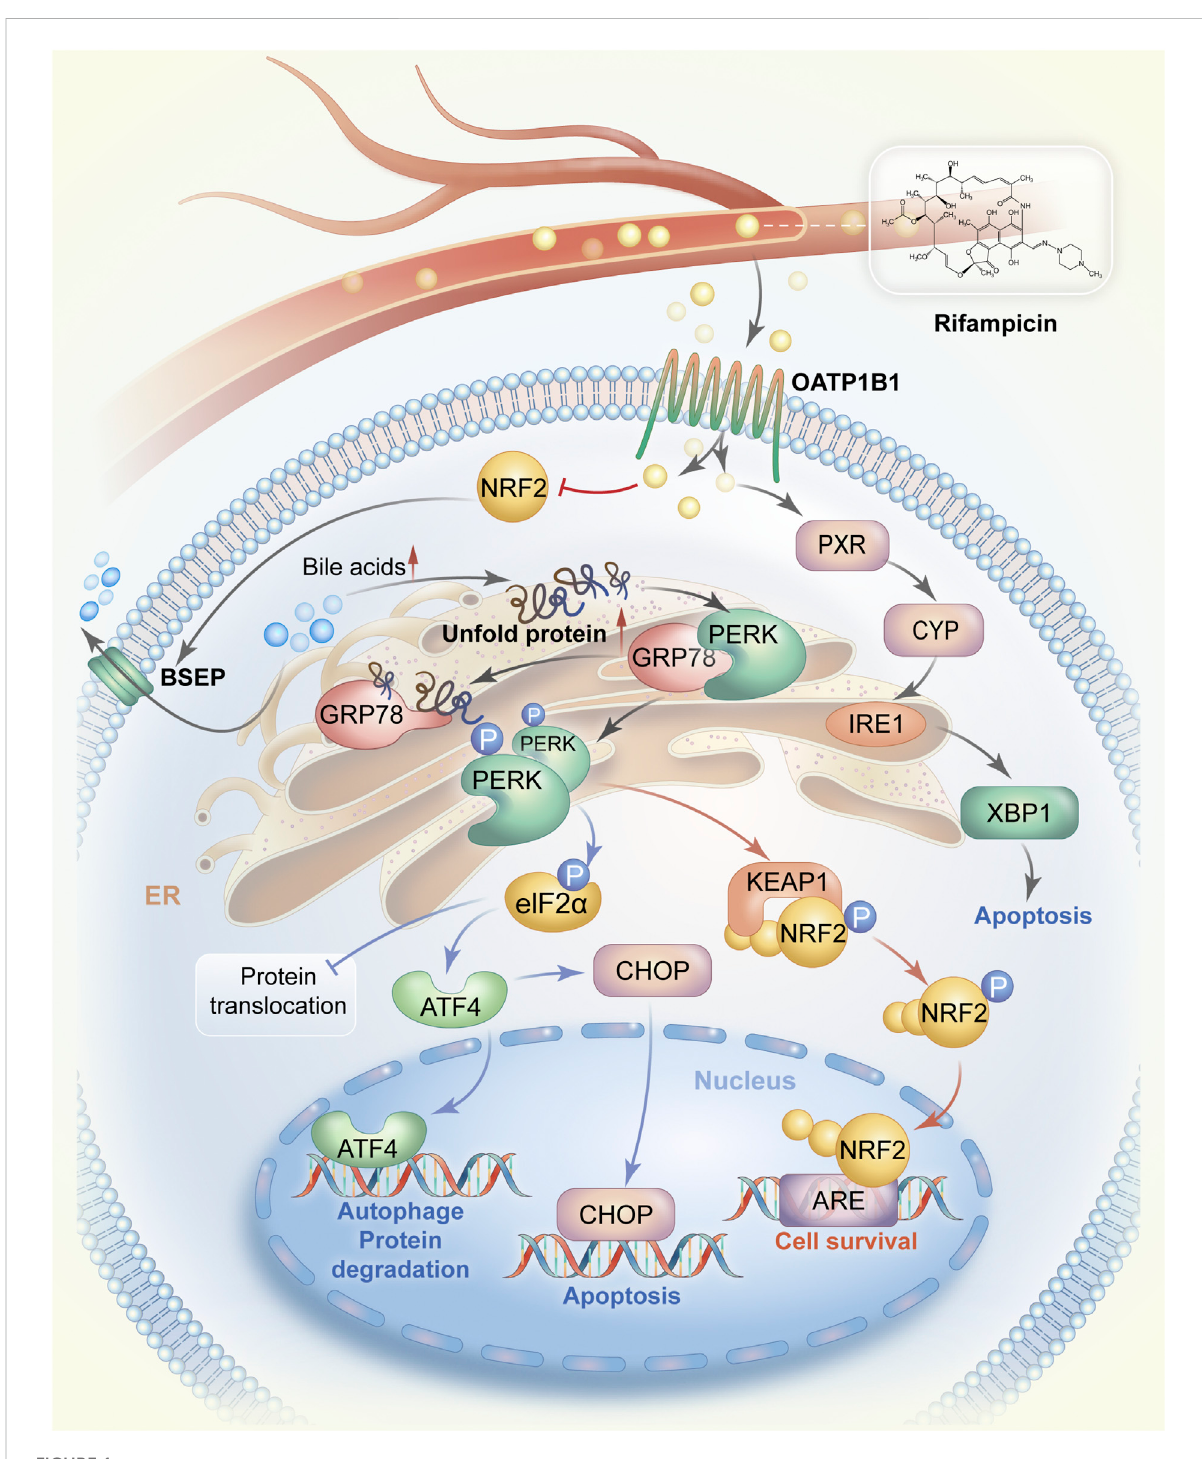
The mechanistic pathways by which rifampicin induces ER stress. Rifampicin is transported to the liver via blood circulation and enters hepatocytes via OATP1B1. Rifampin can stimulate the expression of CYP enzymes by activating PXR and then promote the IRE1-XBP1 signaling pathway to cause ER stress, resulting in cell apoptosis. On the other hand, after entering hepatocytes rifampicin reduces the expression of BSEP possibly by suppressing the activity of NRF2, leading to the accumulation of bile acids in hepatocytes. Accumulated bile acids interrupt protein foldingandcausealargeamountofunfoldedprotein.TheunfoldedproteincompetestobindGRP78alsoknownasBiPintheGRP78/PERKcomplex, allowing PERK activation. PERK homodimerization occurs after being phosphorylated. The PERK dimer activates the ATF4-CHOP signaling pathway and promotes cell survival by switching on the NRF2-dependent self-protection mechanism. Abbreviations: ER, endoplasmic reticulum; OATP1B1, organic anion transporting polypeptides1B1; CYP, cytochrome p450; PXR, pregnane X receptor; IRE1, Inositol-requiring enzyme 1; XBP1, X-box bindingprotein1;GRP78,glycoregulatory protein78; PERK, proteinkinaseR-likeendoplasmicreticulum kinase;ATF4, transcriptionfactor4;CHOP, CCAAT/enhancer binding protein homolog protein; NRF2, nuclear factor E2-related factor